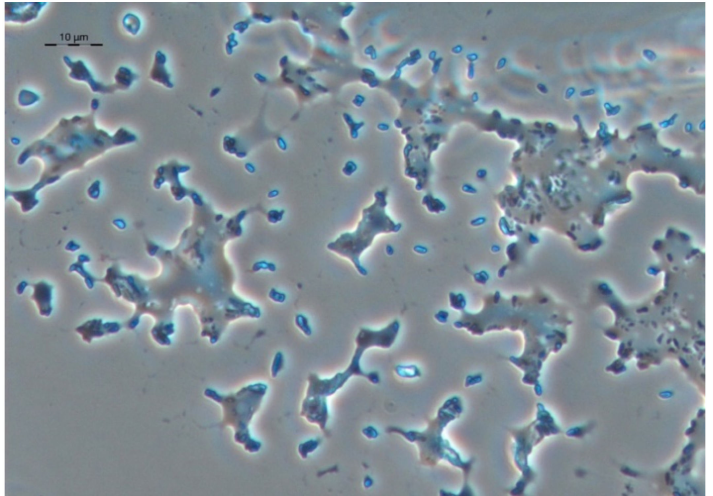
Figure 11. R. qingshengii strain VT6 in a drop on hexadecane 4 days of growth. Light microscopy, phase contrast. The length of the scale mark is 10 µ